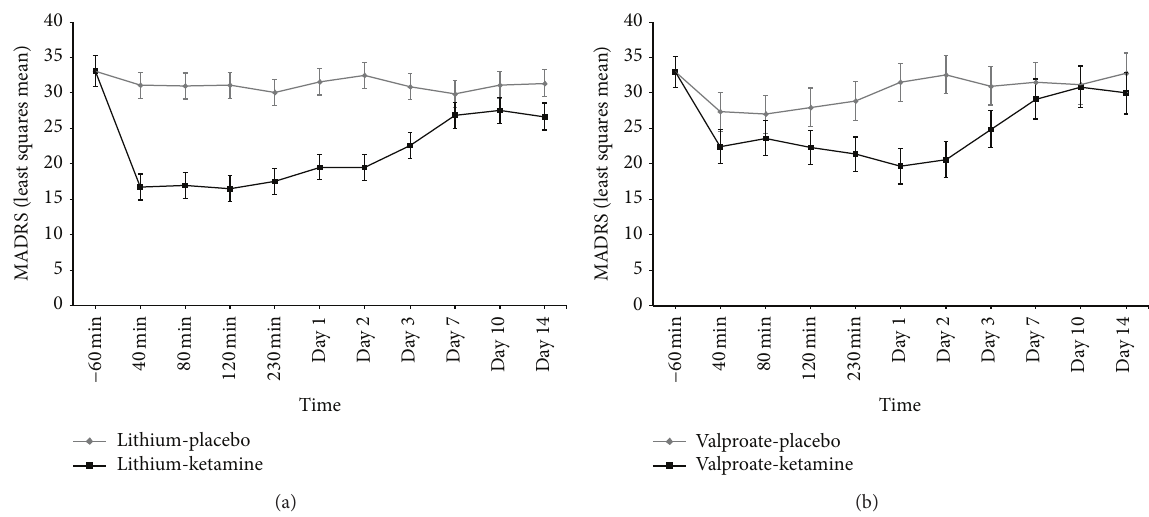
Figure 1: Rapid and sustained antidepressant effects of ketamine in treatment-resistant bipolar depressed patients maintained on therapeutic- dose lithium and valproate. Twenty-three subjects with treatment-resistant bipolar disorder (BD) receiving lithium (a) and 13 receiving valproate (b) currently experiencing a major depressive episode were randomized to either subanesthetic dose ketamine (0.5mg/kg × 40min) or placebo infusion in a randomized, placebo-controlled, crossover trial. Ketamine had antidepressant efficacy in both lithium-maintained and valproate-maintained patients (drug-by-mood stabilizer interaction ( 𝐹 1,125 = 8.26 , 𝑝 = 0.005 )) but there was no statistically significant antidepressant difference between lithium and valproate ( 𝐹 1,28 = 2.51 , 𝑝 = 0.12 , and 𝑑 = 0.60